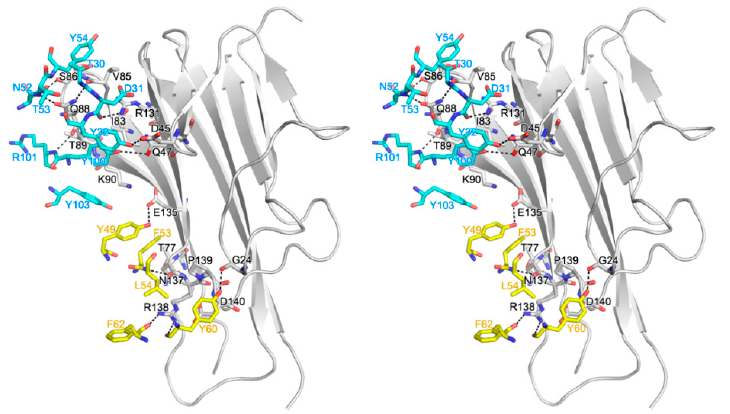
Figure 2. TNF α -certolizumab Fab fragment interface. Cross-eyed stereoview of the detailed TNF α -certolizumab Fab fragment interface. The carbon atoms from TNF α and the heavy and light chains of certolizumab are colored gray, cyan, and yellow, respectively. Hydrogen bonds are indicated with dashed lines.